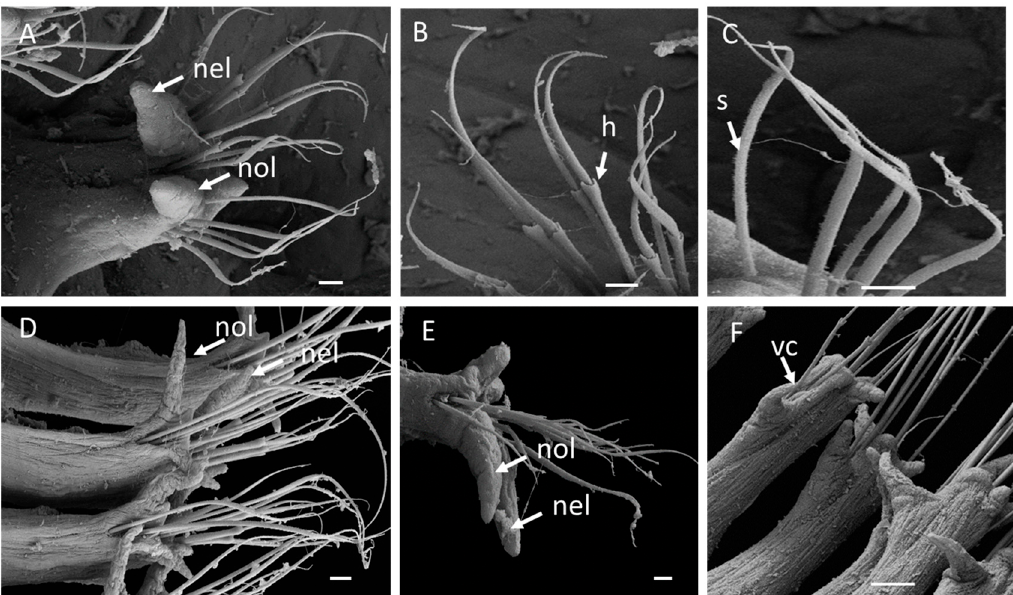
Figure 4. Glycera sheikhmujibi n. sp. SEM images of the ( A ) anterior parapodium, ( B ) compound neurochatae, ( C ) capillary notochaetae, ( D ) mid-body parapodia, ( E ) posterior parapodium, and ( F ) posterior end parapodia. h: homogomph spinigers, nol: notopodial lobe, nel: neuropodial lobe, s: spines, vc: ventral ciri. Scale bars: A, B, C, and E = 10 µm; D = 20 µm; F = 30 µm.